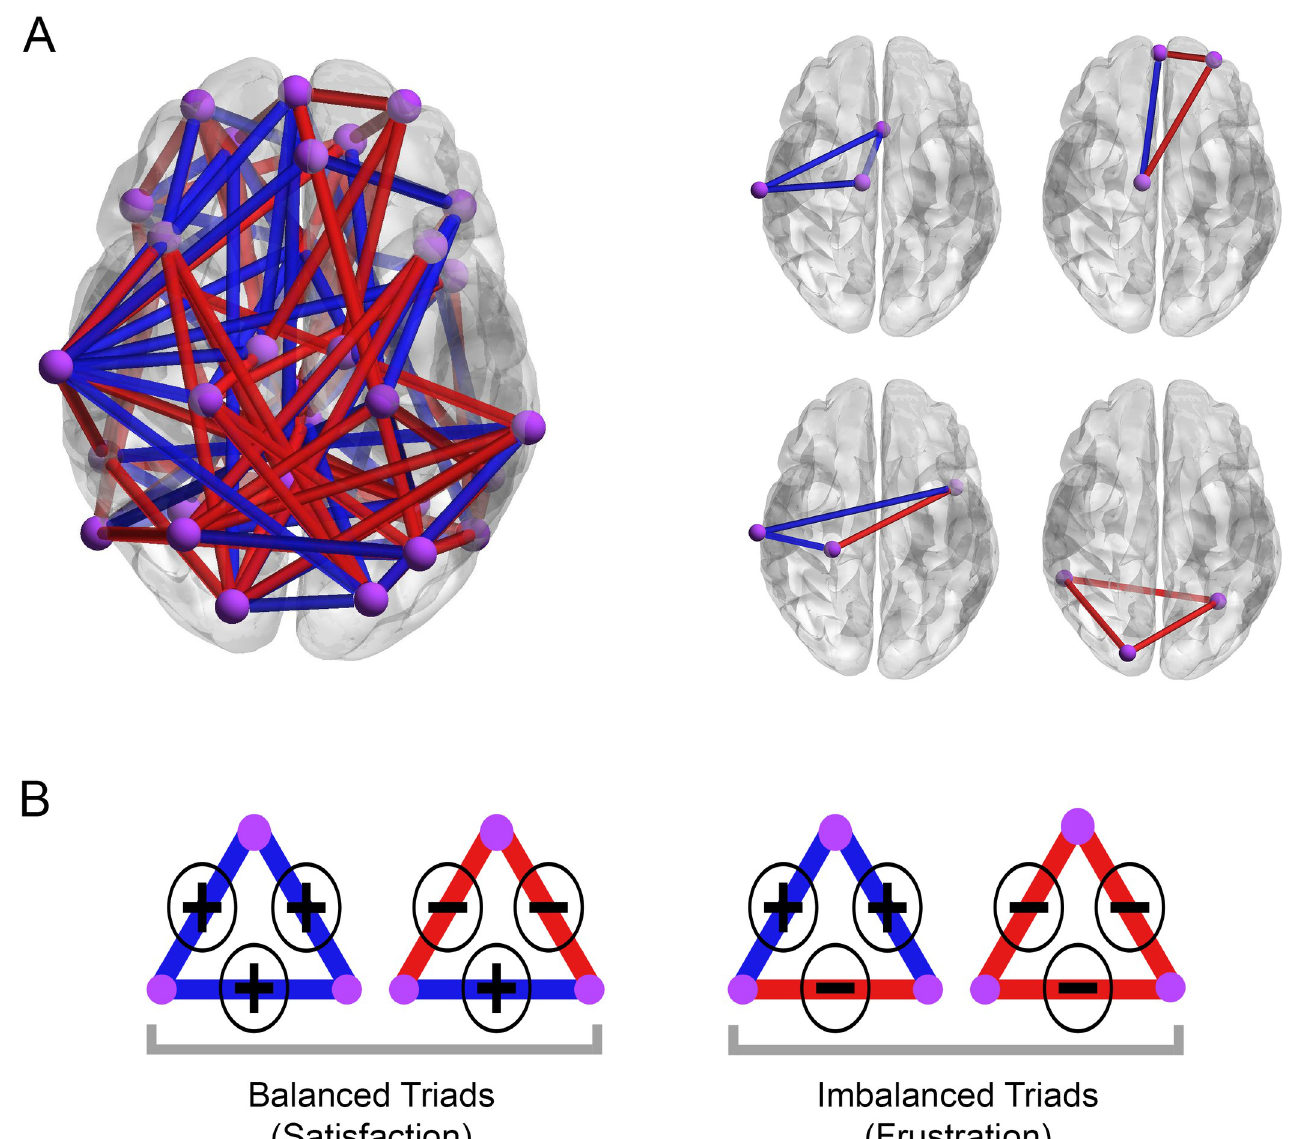
Fig 1. (A) A brain signed network and formation of closed triadic relations. Violet nodes reflect brain regions, and blue and red links correspond to positive and negative functional connections. (B) Classification of possible closed triadic types based on inter-entity conflicts and Heider’s balance